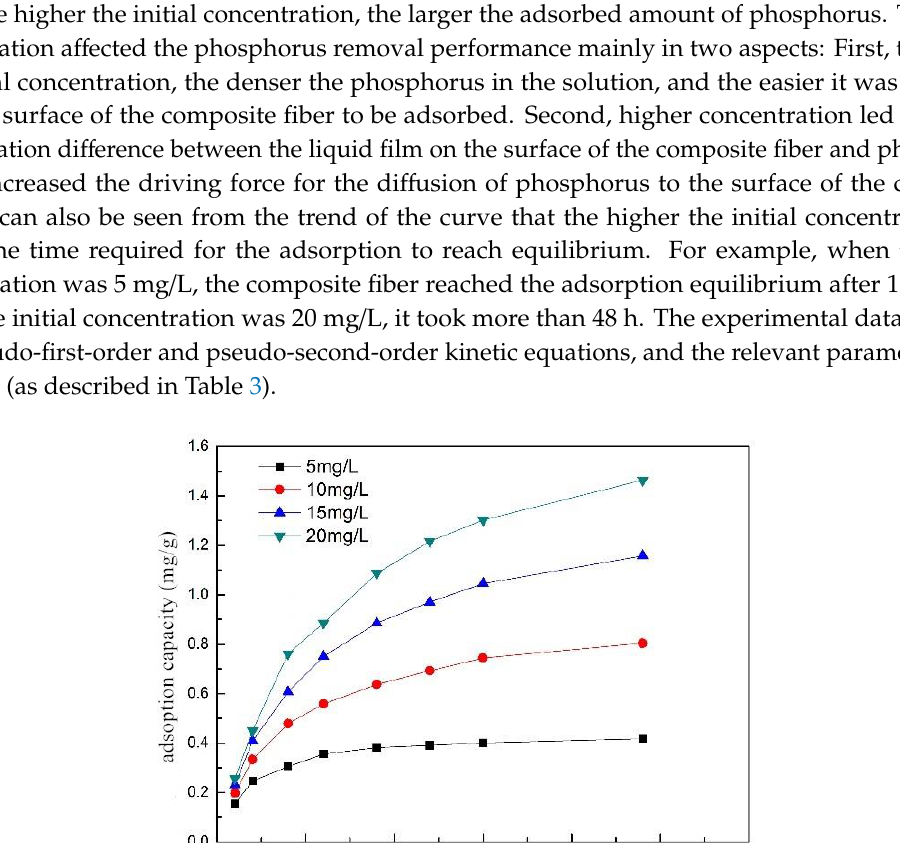
Table 3. Kinetics of phosphorus removal by ZSFB composite fiber at different initial concentrations.